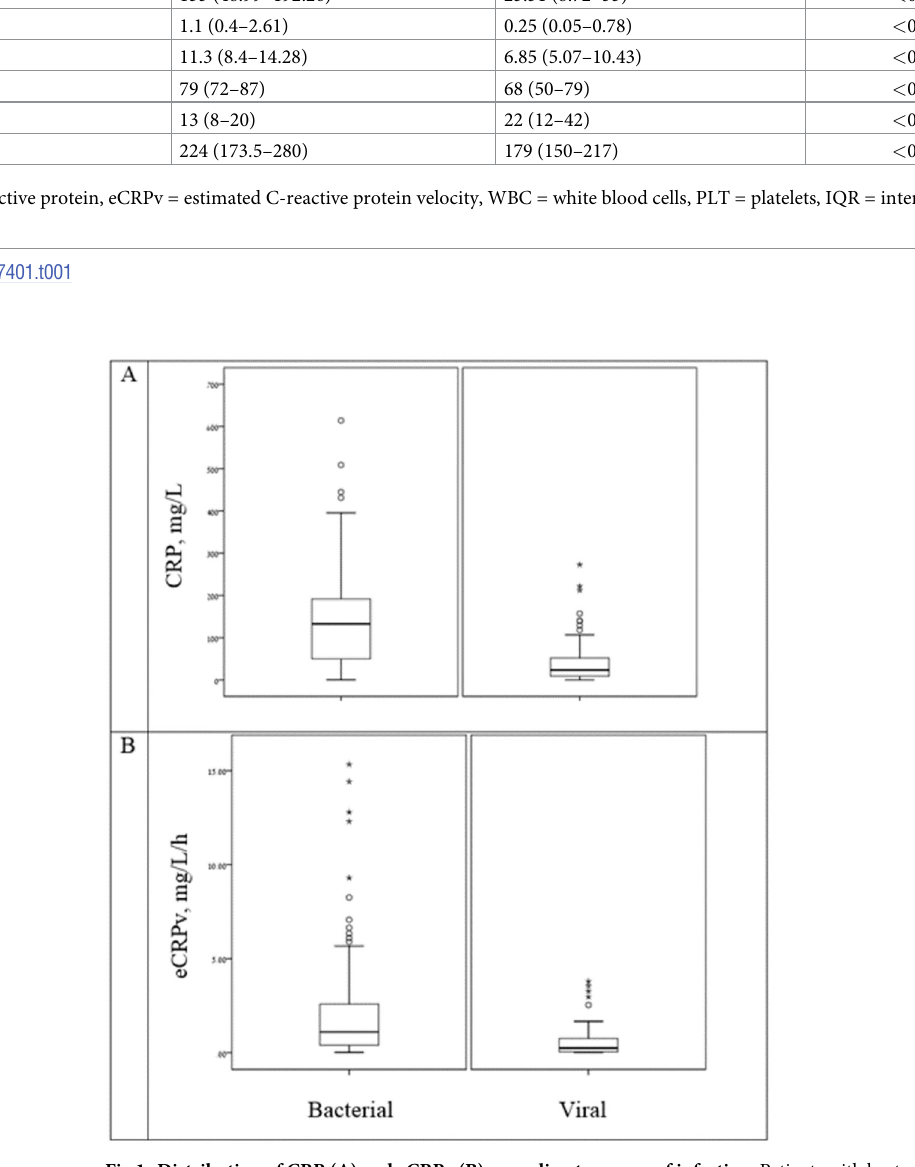
Fig 1. Distribution of CRP (A) and eCRPv (B) according to source of infection. Patients with bacterial infections presented with higher CRP levels upon ED admission and higher eCRPV levels compared to patients with viral